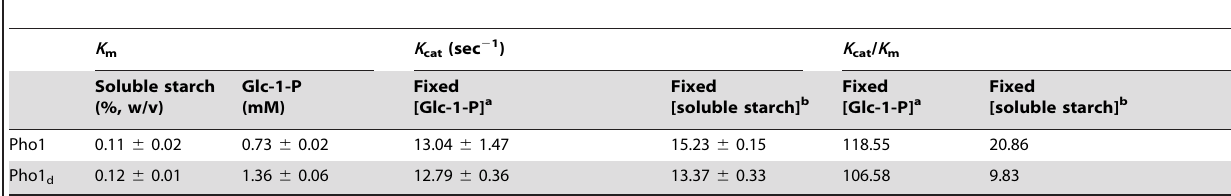
Table 1. Enzyme kinetic analysis of intact Pho1 and degraded Pho1 (Pho1 d ) in the starch synthesizing direction.